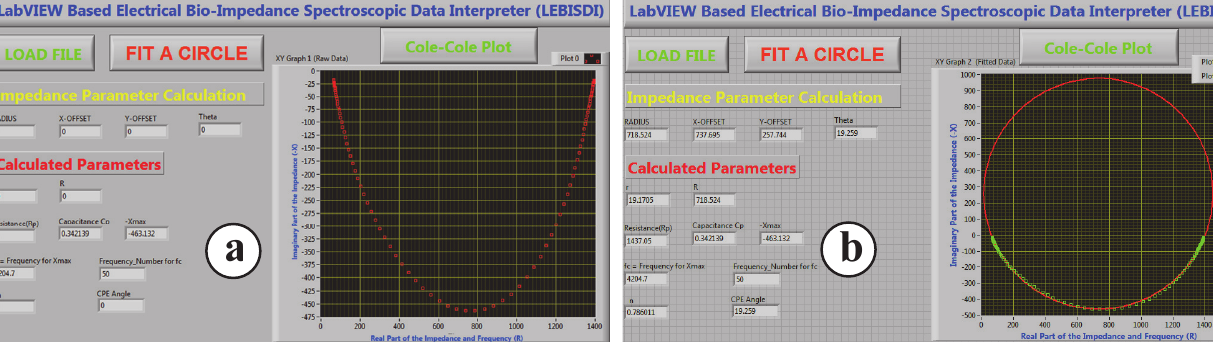
Fig.15: Impedance data fitting and analysis in LEBISDI for a cucumber. (a) Before fitting: data loaded. (b) After fitting: data calculated.